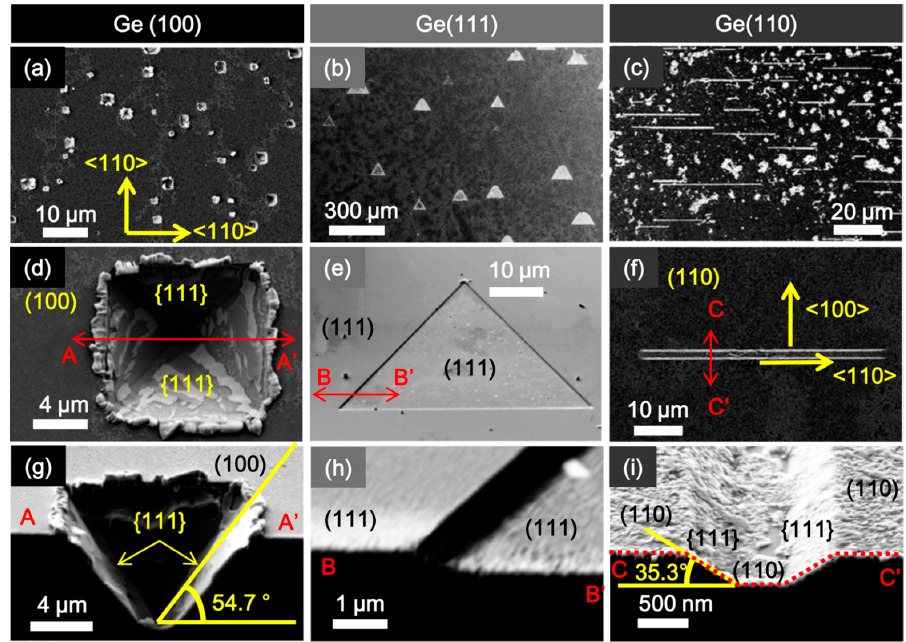
Figure 2. SEM images of the etch pits for different orientations of single-crystal Ge. ( a – c ) Morphology of the anisotropically etched surface. Top (( d – f )) and side (( g – i )) views of SEM images showing a single etch pit on etch orientation. ( a , d , g ) Ge (100) crystal plane. ( b , e , h ) Ge (111) crystal plane. ( c , f , i ) Ge (110) crystal plane [41]. Reproduced with permission from American Vacuum